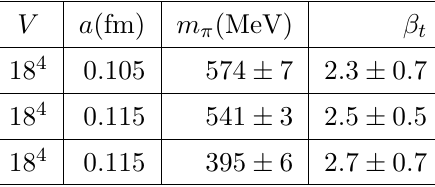
Table 7 . The tensor polarizability (cid:12) t of the (cid:26) (cid:6) is represented for various lattices and pion masses.